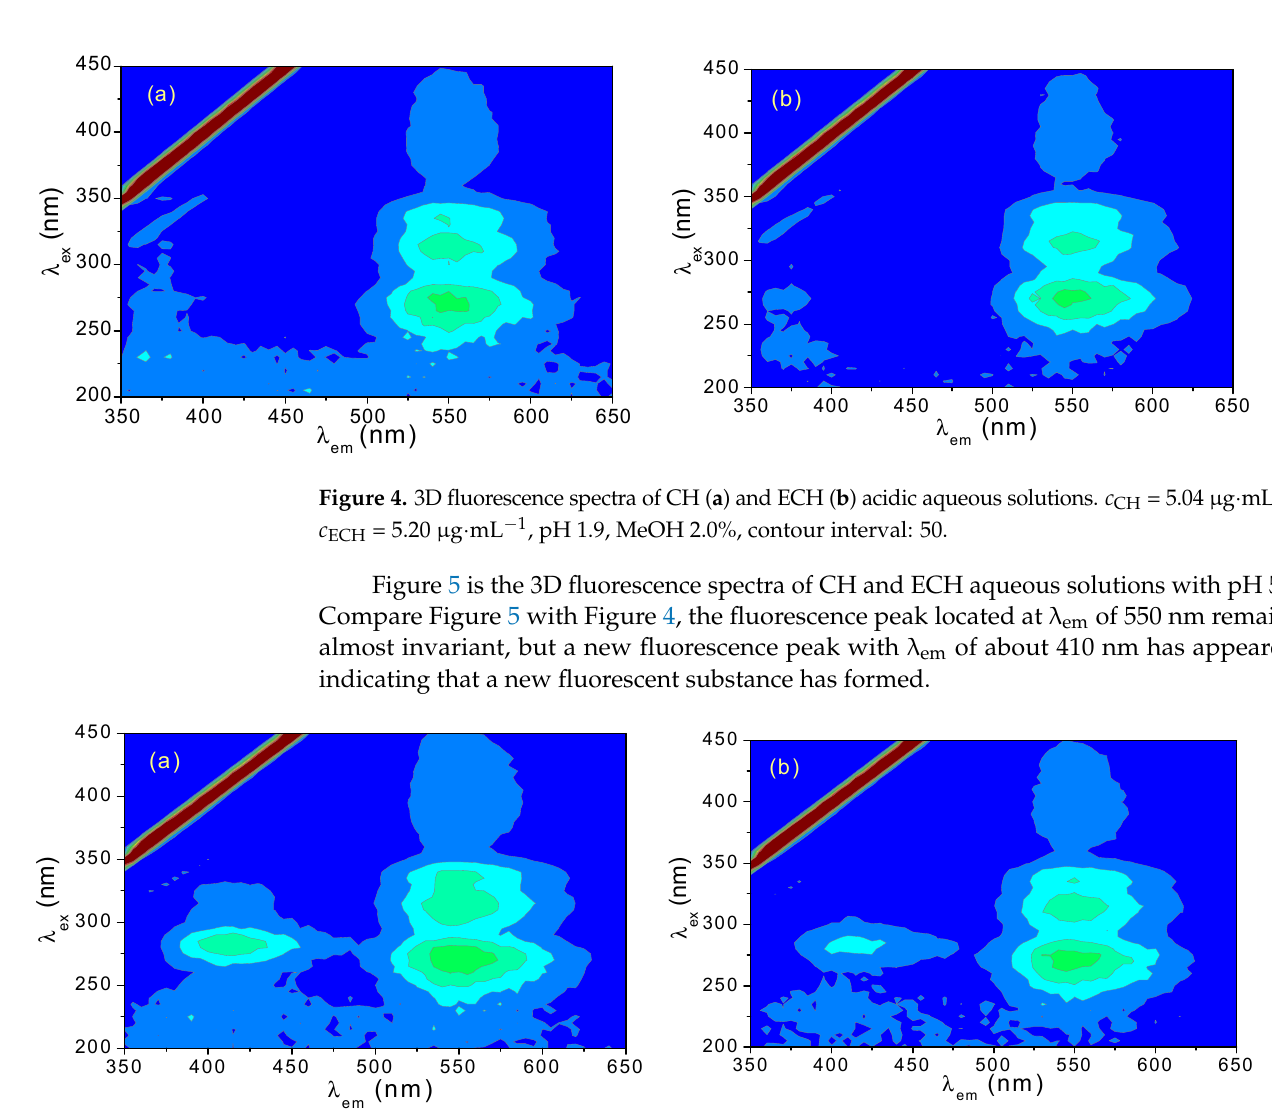
Figure 5. 3D fluorescence spectra of CH ( a ) and ECH ( b ) aqueous solutions. c CH = 5.04 μ g·mL − 1 , c ECH = 5.20 μ g·mL − 1 , pH 5.7, MeOH 2.0%, contour interval: 50.